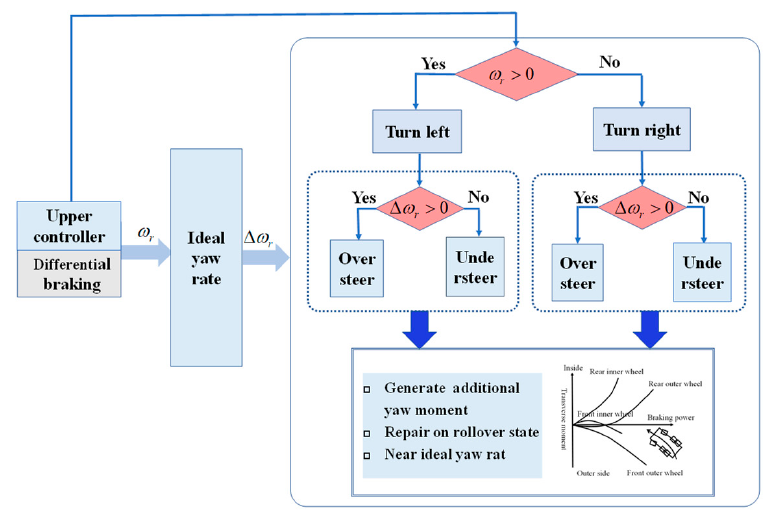
Figure 6. Differential braking control logic diagram.